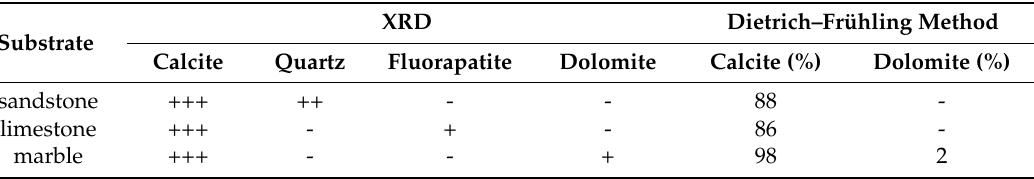
Table 1. Results of XRD analysis (+++: dominantly present, ++: present, +: traces) and calcite and dolomite content (%) measured by the Dietrich–Frühling gas volumetric method.